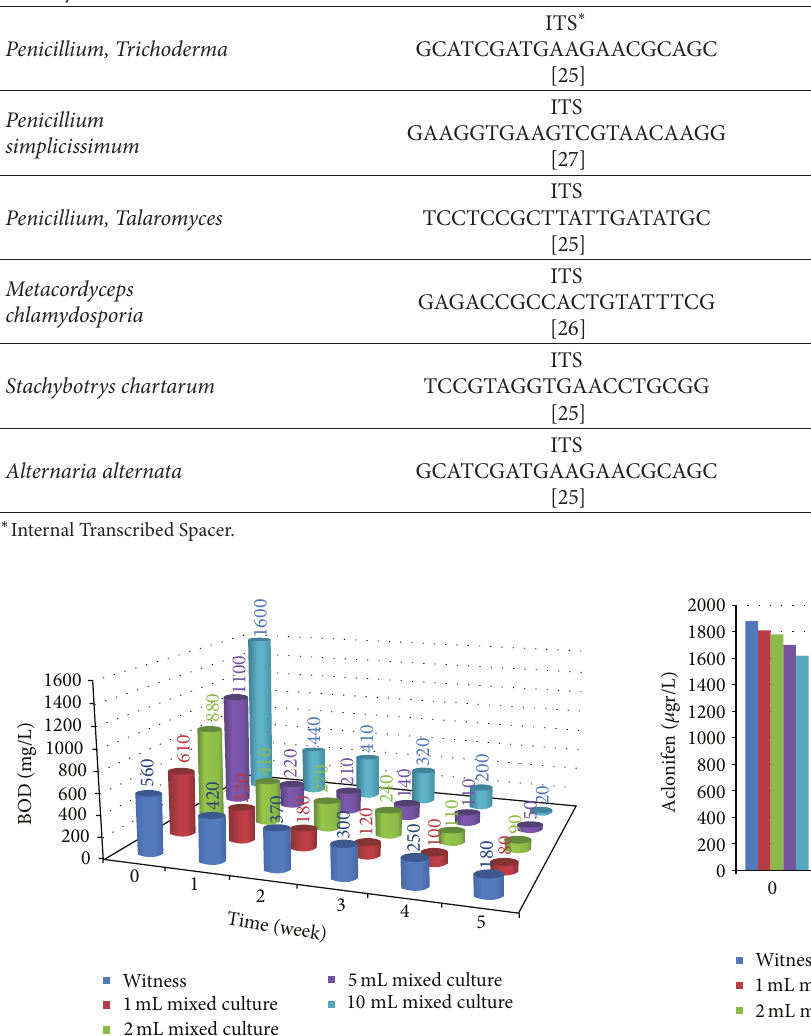
Figure 5: Aclonifen remediation results in the filtrate.